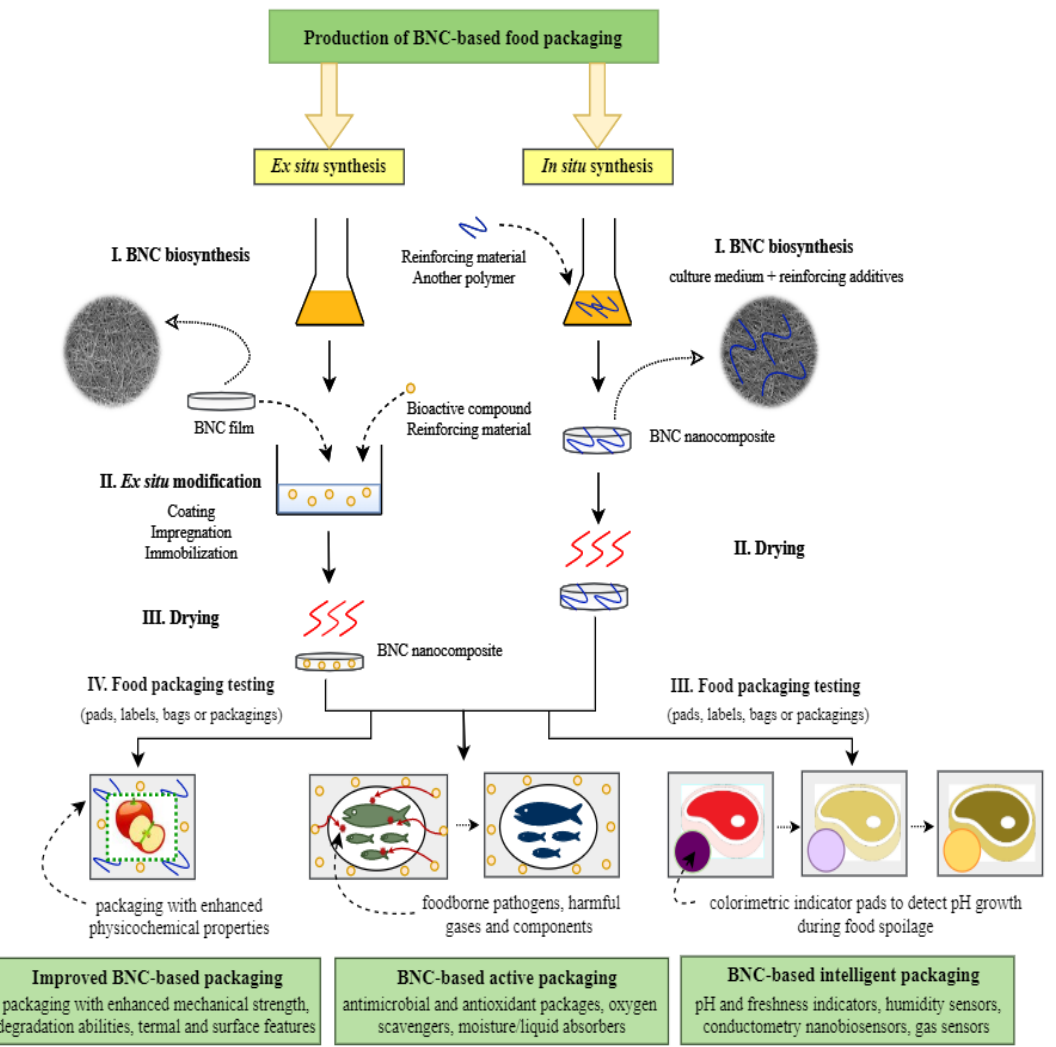
Figure 2. The steps of bacterial nanocellulose (BNC)-based food packaging production.